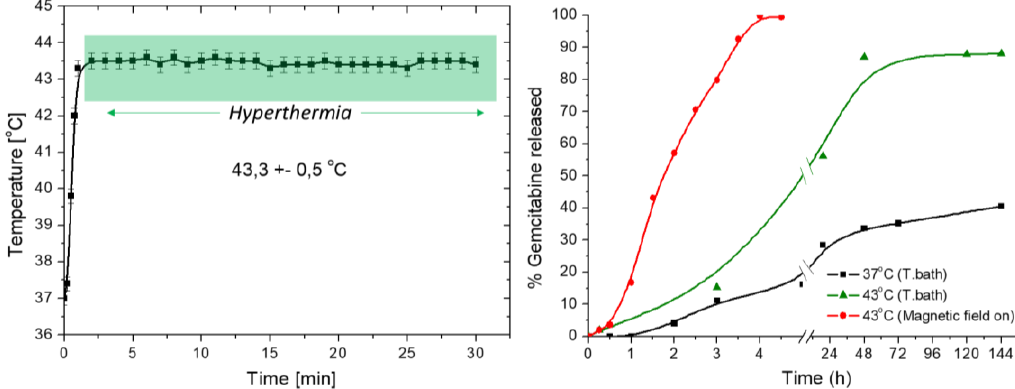
Figure 9. ( a ) Typical hyperthermia and drug release experiment with manually stabilized magnetic field strength; ( b ) GEM release profile for thermostatic bath at 37 °C, 43 °C, and magnetic field hyperthermia set at 43 °C.